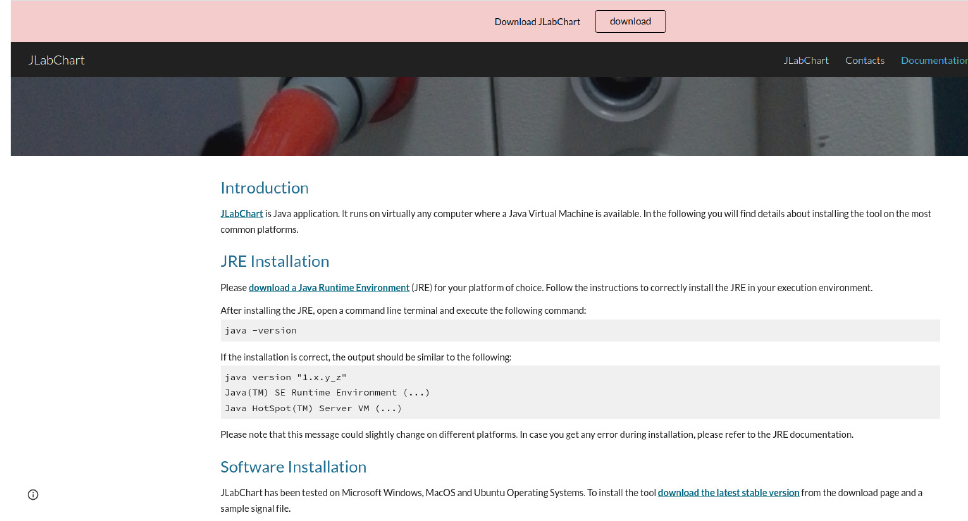
Figure 7. JLabChart download page.